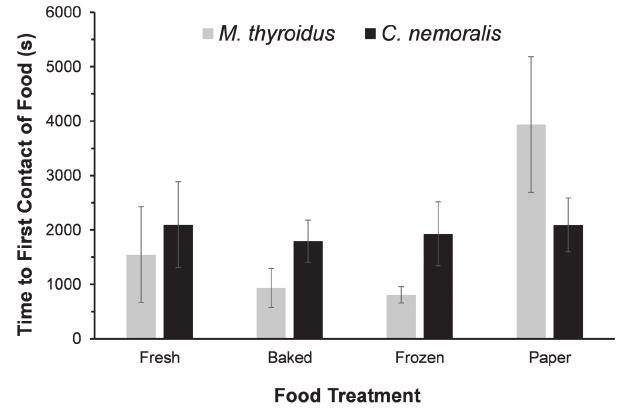
Figure 2. Mean ( ± SE) food detection times of native M. thyroidus (gray) and introduced C. nemoralis (black) snails across different food treatments.